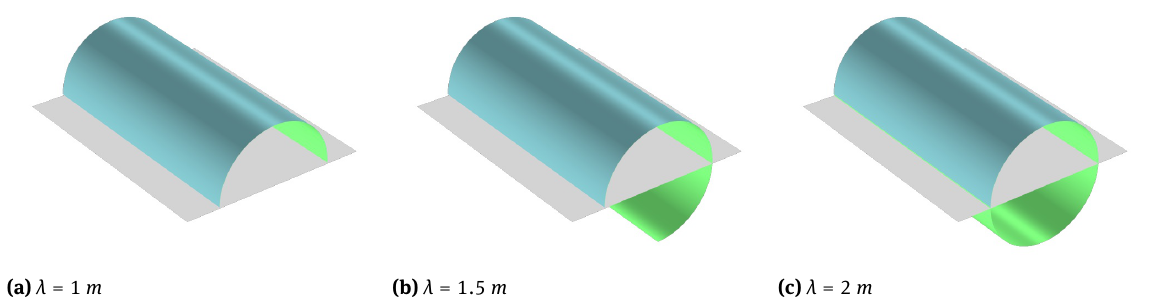
Figure 6: Effects of the membrane distortion at constant curvature of a cylindrical shell. Each of the three figures shows the computational domain (gray), and the actual surface (cyan up and green at bottom) for three different values of the stretch λ . Each deformed configuration is stress-free.